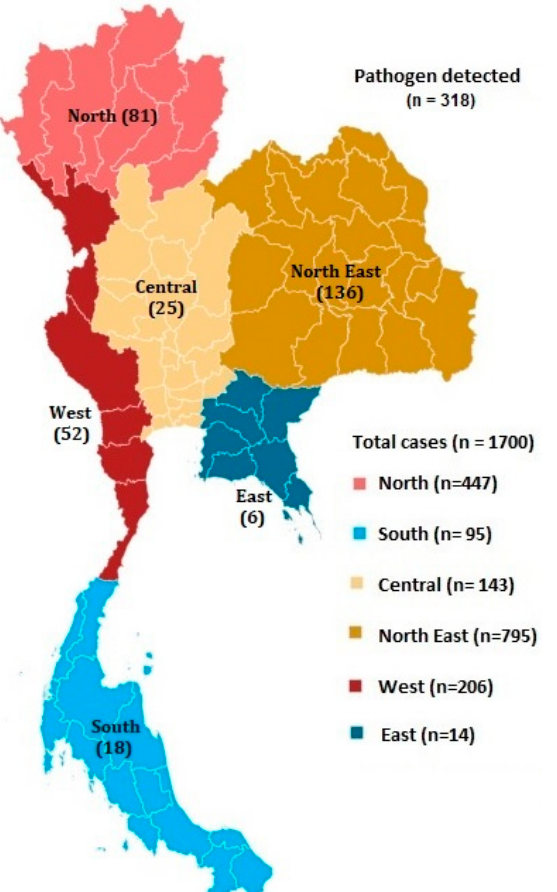
Figure A1. Geographic distribution of patients with suspected encephalitis in Thailand from 2013 to 2018. A map showing number of positive cases in different regions.